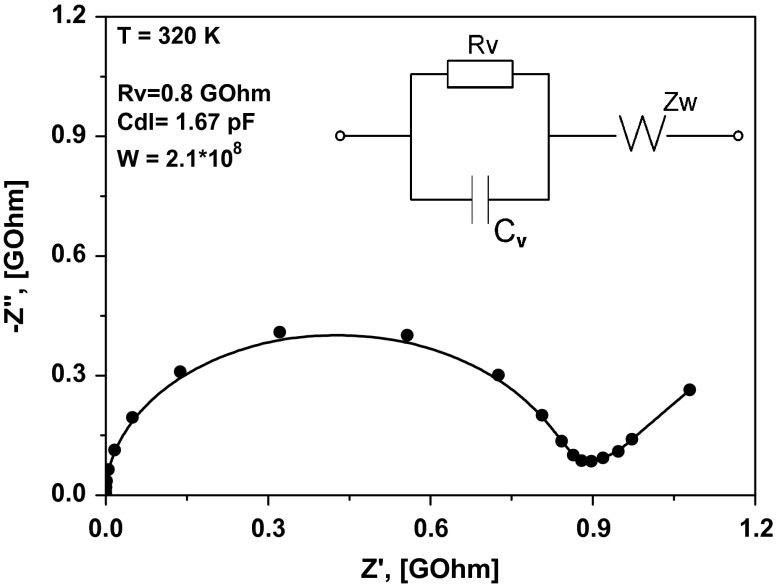
Nyquist plot for the heterostructure with d = 20 nm measured at 320 K (solid circles). The inset shows the equivalent circuit that was used in the fit (solid line).